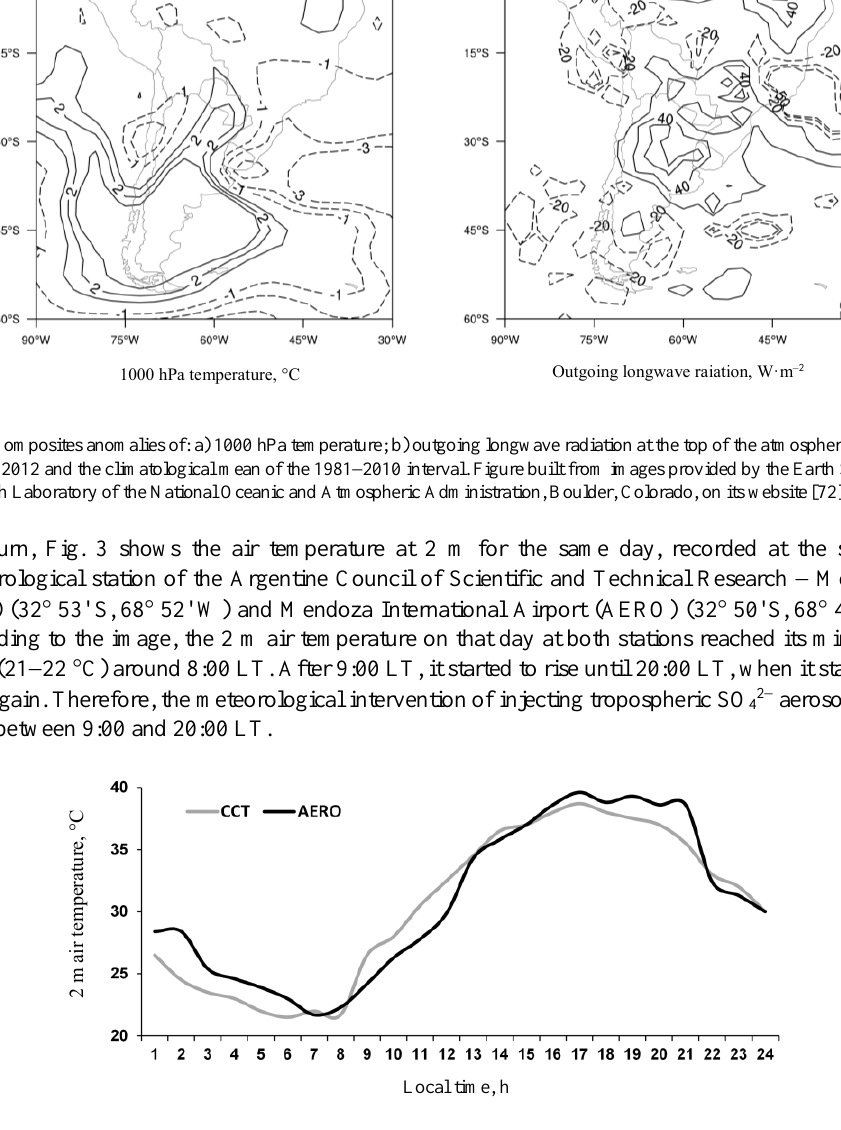
Fig. 4 shows the radiosounding for 8 January 2012 at 9:00 LT. The air temperature curve observed indicates that the air layer located at around 600 hPa (~ 4 km a.s.l.) and 850 hPa (~2 km a.s.l.) has a positive atmospheric stability. This situation determines that the rise of an artificial sulfate injection will be limited by the stability of those two layers. The air temperature